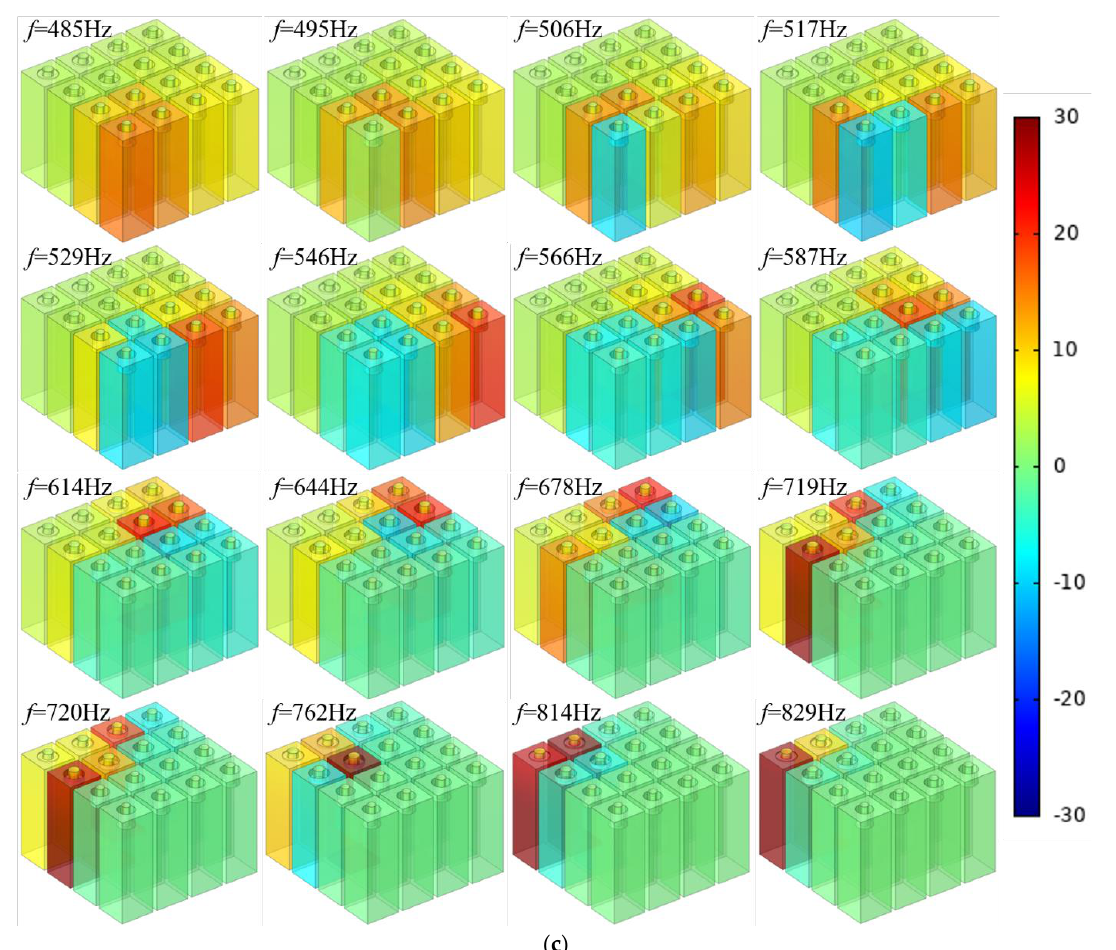
Figure 8. Distributions of the sound pressure at each resonance frequency for the three optimized metamaterial cells: ( a ) Condition − 1; ( b ) Condition − 2; ( c ) Condition −